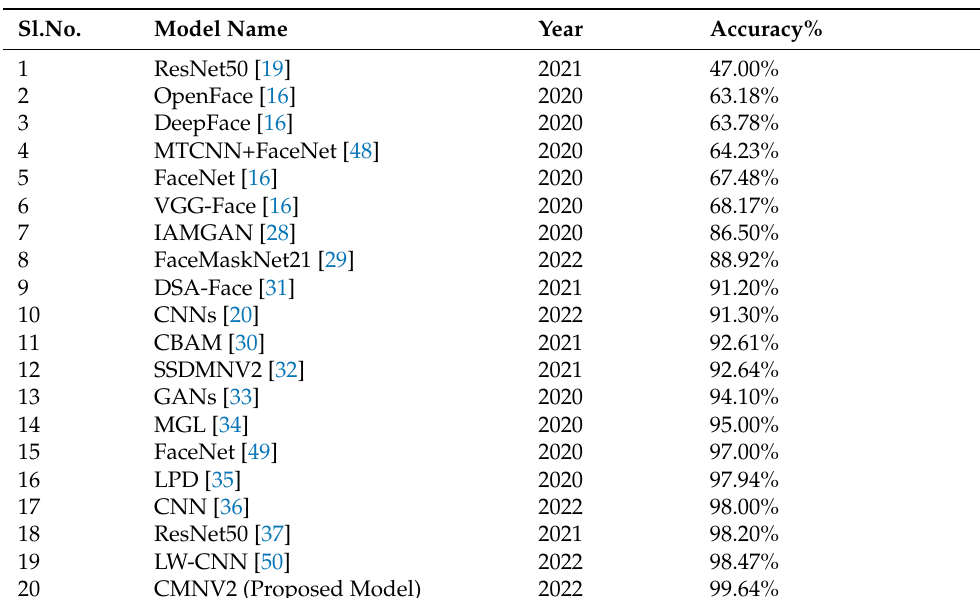
Figure 13. Comparison graphs of various dimension images: ( a ) accuracy, precision ( b ) recall and f1-score and ( c ) error rate of MobileNetV1 and MobileNetV2 implemented along with Caffe model. Table 4. Comparison of various models’